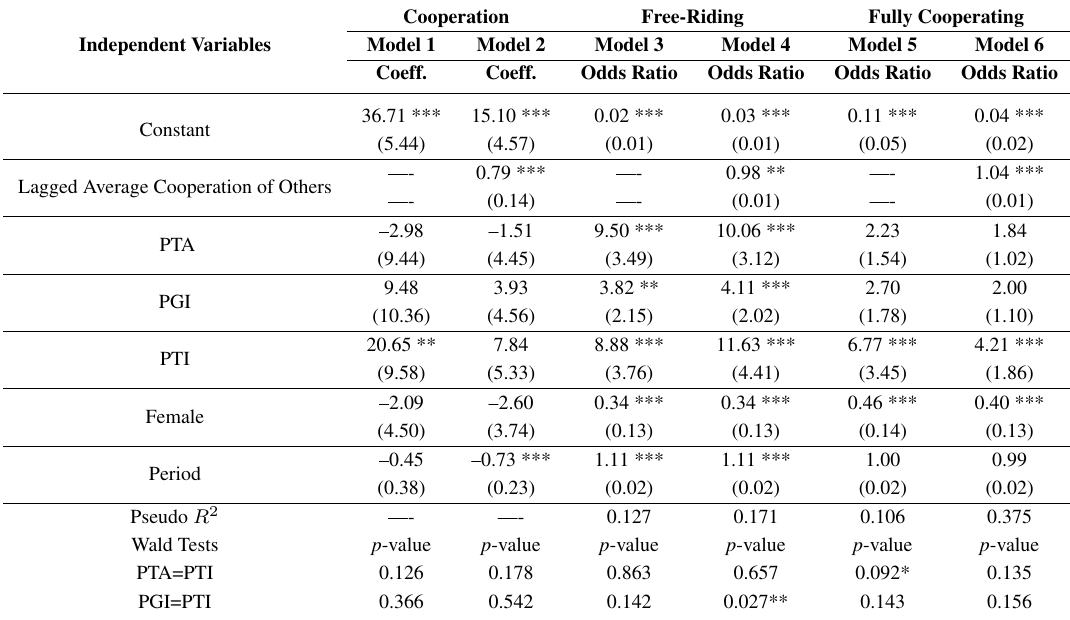
Table 4. Individual-Level Regressions: Average Cooperation, Free-Riding, and Fully Cooperating